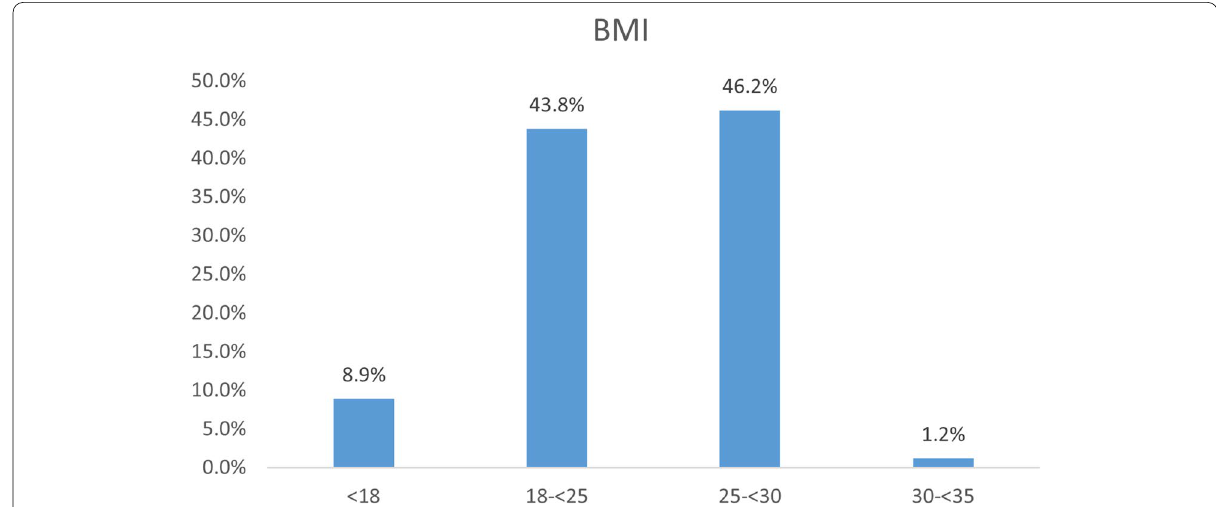
Fig. 2 The body mass index of the patients at